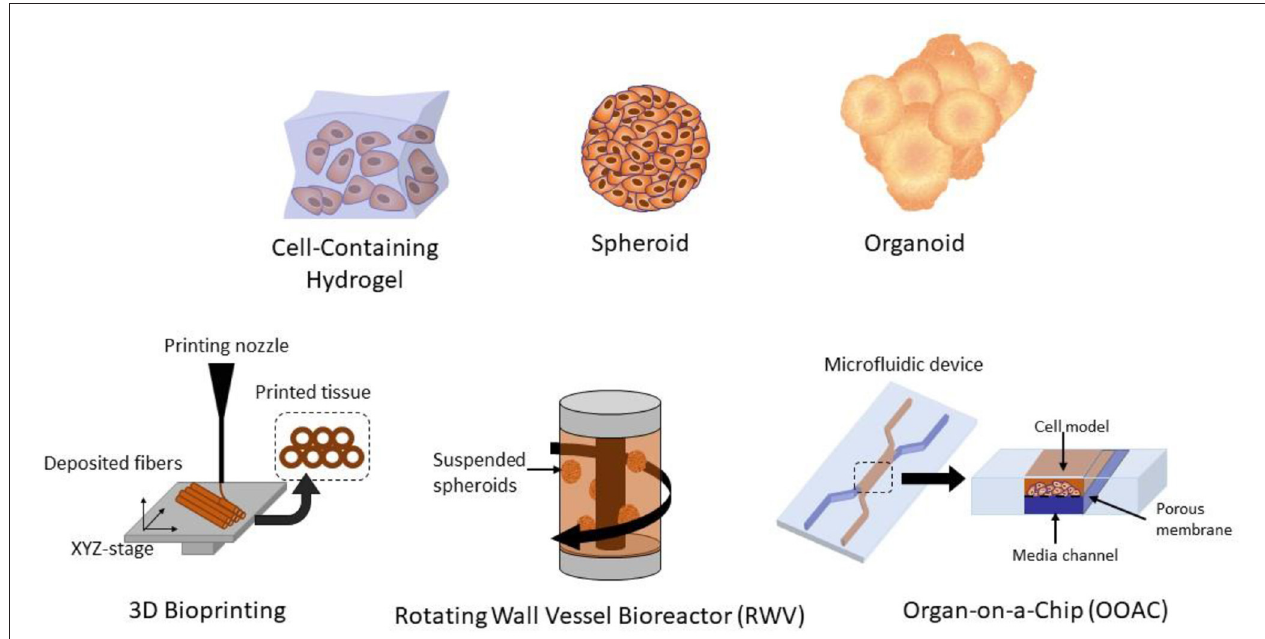
FIGURE 2 | Different methods of 3D cell culture, including 3D hydrogels, spheroids, organoids, 3D bioprinted tissues, organ-on-a-chip (OOAC), and rotating wall vessel (RWV)